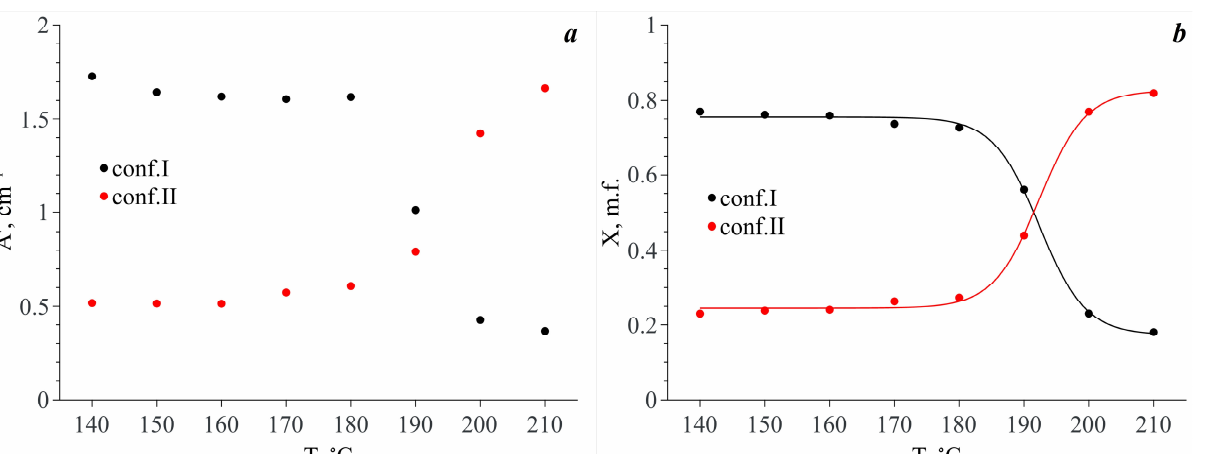
A (cid:48) i X A' / A' i i